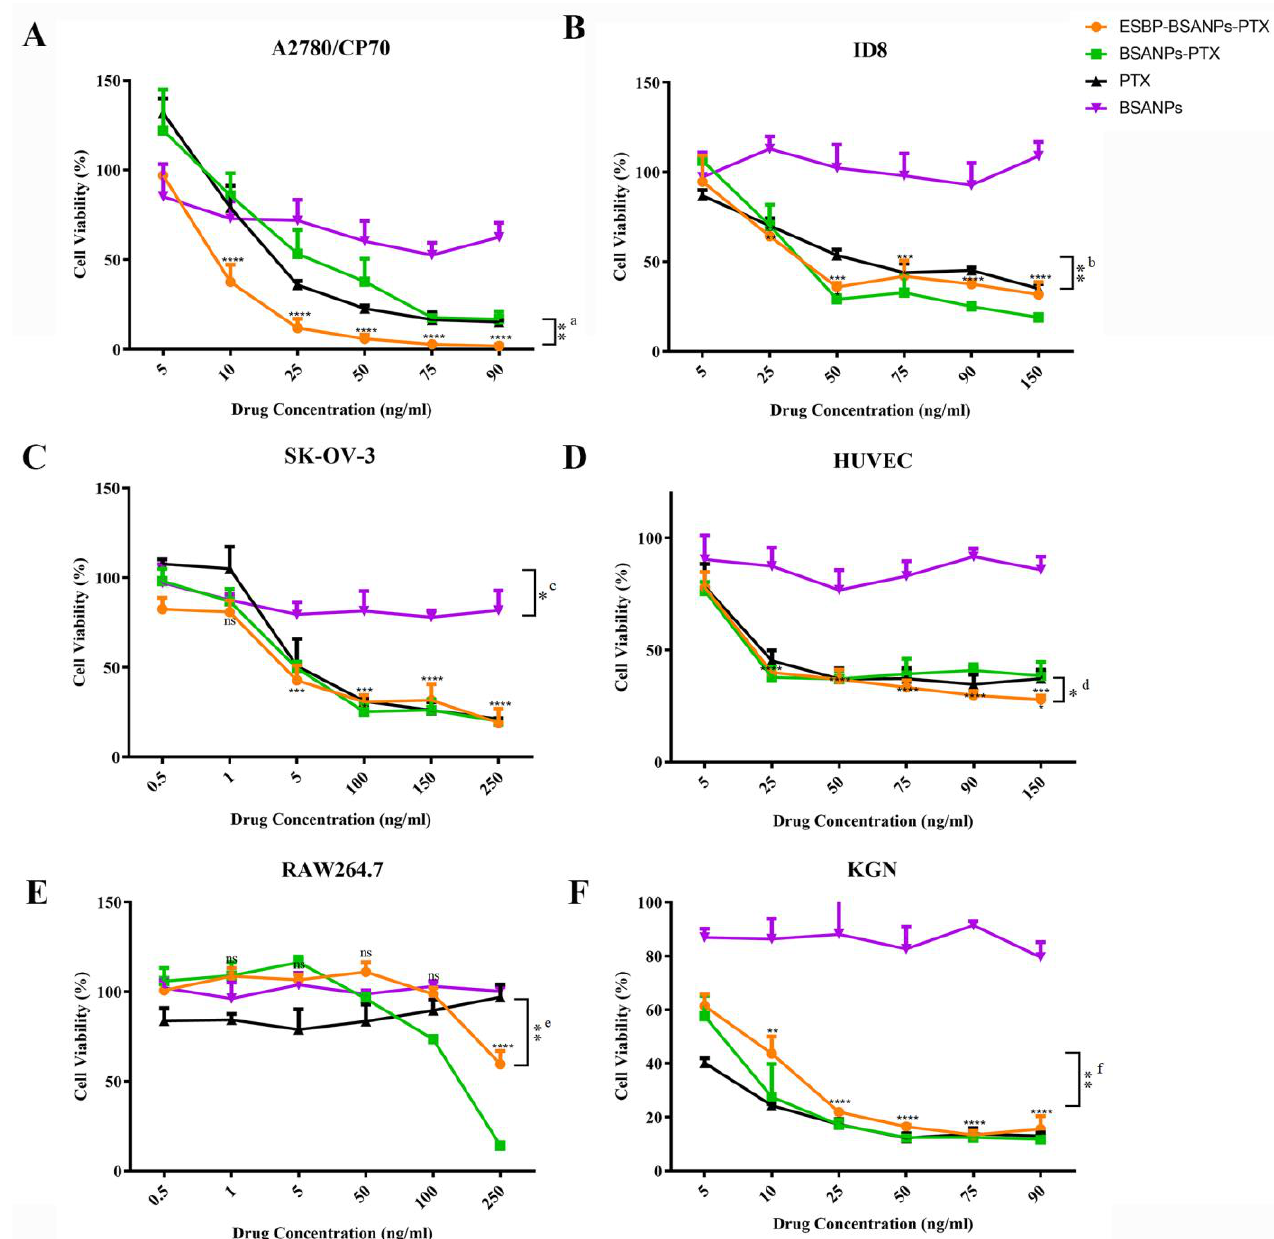
Figure 2. Cell viability of ovarian cancer cell lines (( A ) A2780/CP70, ( B ) ID8, ( C ) SK-OV-3) and ( D ) HUVEC, ( E ) RAW264.7 and ( F ) KGN cells at 72 h time point was analyzed using microplate reader (mean ± SD, n = 3). Serial dilutions of PTX, ESBP-BSANPs-PTX, BSANPs-PTX and BSANPs were added to cells to final drug concentrations ranging from 0.5 ng/mL to 250 ng/mL for RAW264.7 and SK-OV-3; 5 ng/mL to 90 ng/mL for A2780/CP70 and KGN; and 5 ng/mL to 150 ng/mL for HUVEC and ID8. The cell viability of the vehicle (blank) group was considered 100%. The cell viability of each concentration in the ESBP-BSANPs-PTX treatment group was compared with that of the lowest relative concentration in the same group separately, and the statistics are indicated in the graph. The results of the comparison between ESBP-BSANPs-PTX and PTX are shown on the right side of each panel: a **, 25 ng/mL ESBP-BSANPs vs. 25 ng/mL PTX; b **, 50 ng/mL ESBP-BSANPs vs. 50 ng/mL PTX; c *, 1 ng/mL ESBP-BSANPs vs. 1 ng/mL PTX; d *, 150 ng/mL ESBP-BSANPs vs. 150 ng/mL PTX; e **, 250 ng/mL ESBP-BSANPs vs. 250 ng/mL PTX; f **, 10 ng/mL ESBP-BSANPs vs. 10 ng/mL PTX. ns represents p > 0.05; ** p < 0.01, *** p < 0.001 and **** p < 0.0001.